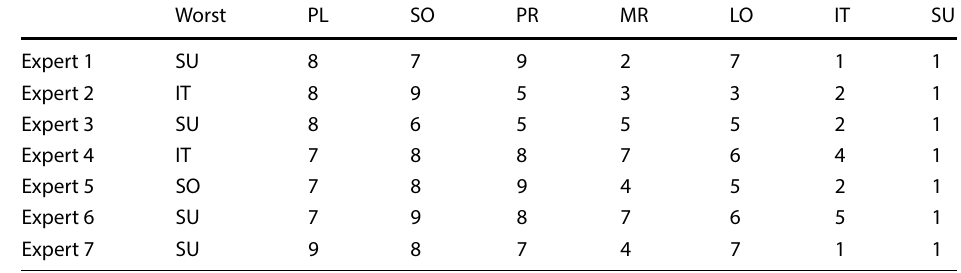
Table 3 Others-to-worst